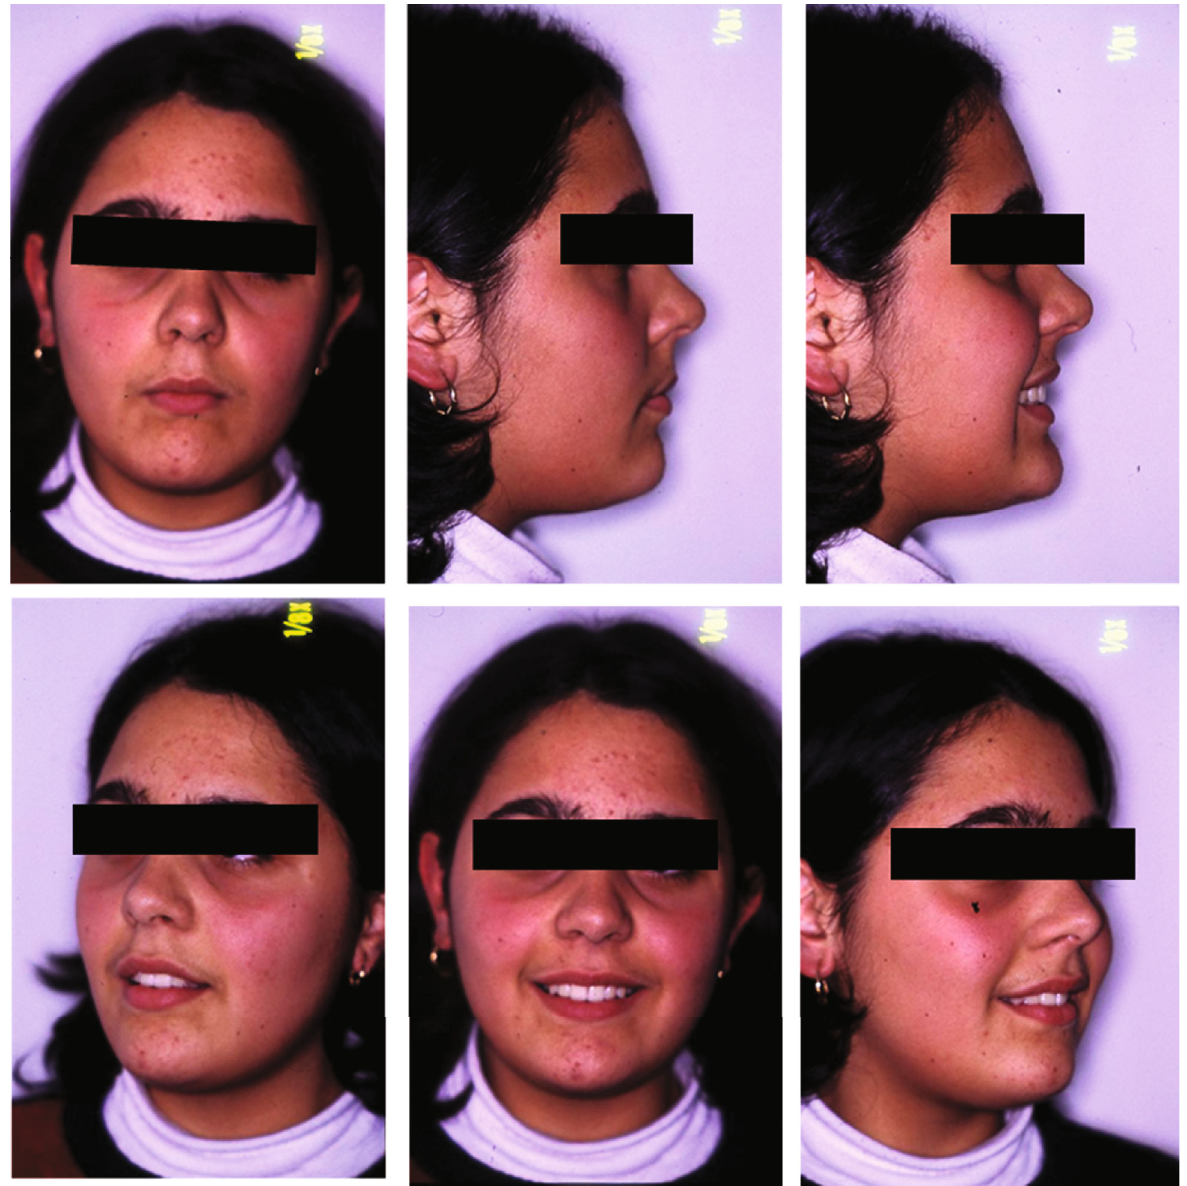
Figure 5: Final extraoral